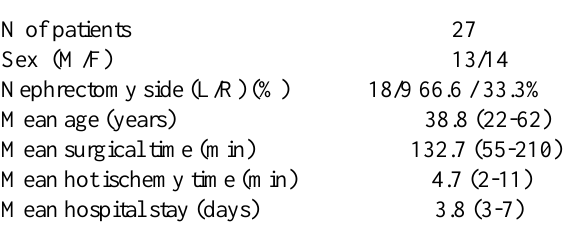
Table 1 – Hand-assisted laparoscopic nephrectomy